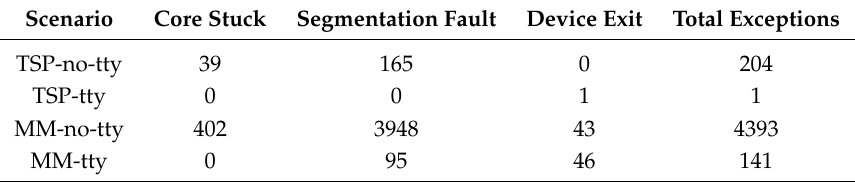
Table 5. Exceptions produced by fault-injection on the 4MR-8Par applications.